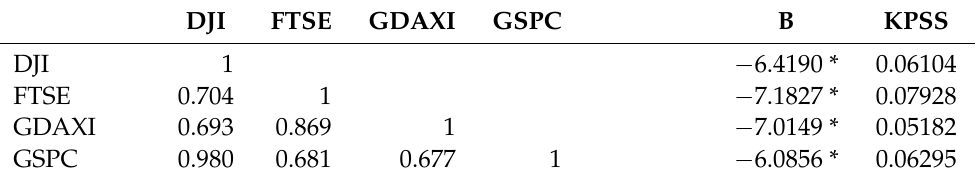
Table 1. Correlation and Unit Root Test—Stock market indices.